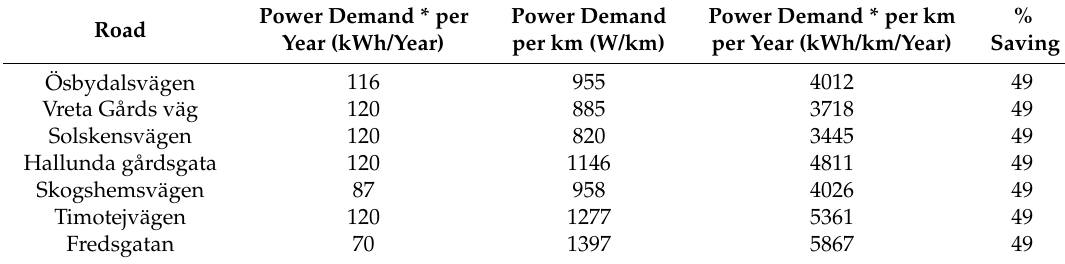
Table 8. Calculated total energy consumption and percentage energy savings for light ‐ emitting diode (LED) lighting on vehicular traffic roads with a dimming schedule applying a 50% reduction between 00:00 and 05:00 A.M., 80% between 05:00 and 07:00 A.M. and 07:00 P.M. to midnight, and 100% for rest of the time between sunset and sunrise. Calculated for Stockholm, Sweden. * = calculated for 4200 burning hours per year.